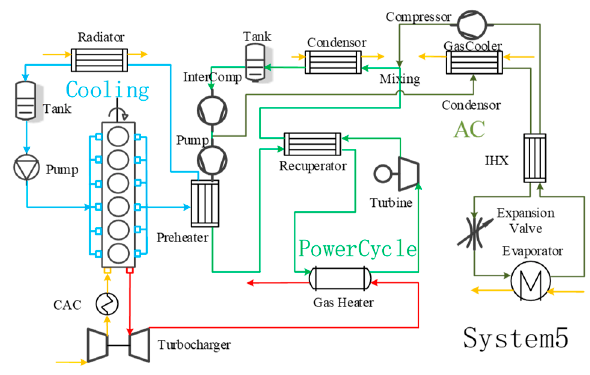
Figure 12. Co-cooling co-compressing secondary compression system.